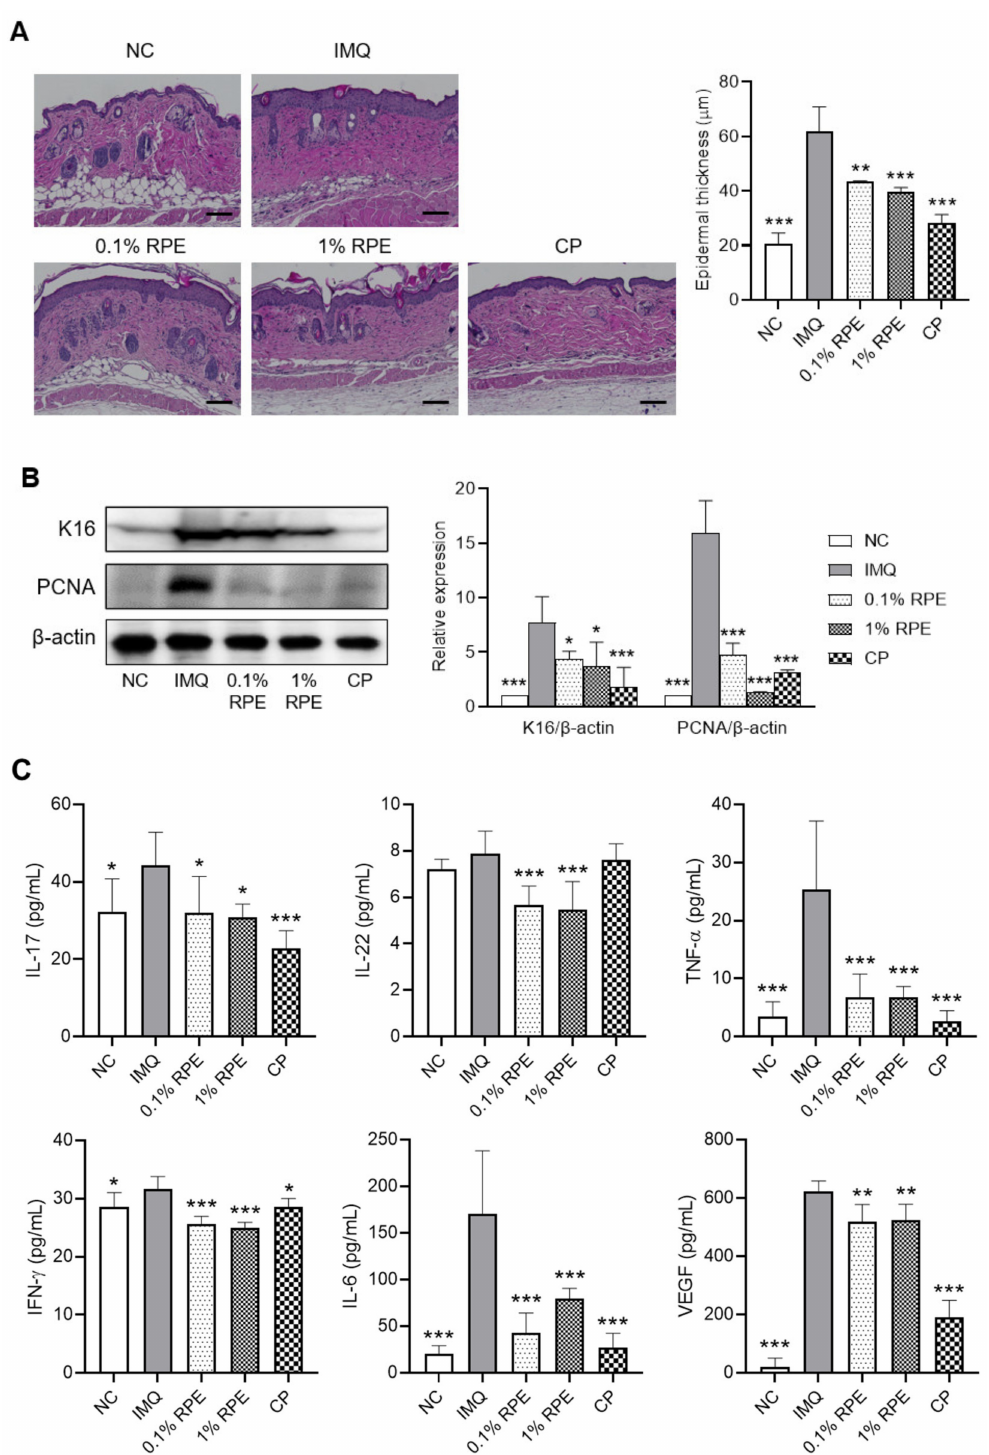
Figure 2. Effects of RPE on epidermal hyperplasia and the expression of proliferation markers and inflammatory cytokines in IMQ-induced mice. ( A ) H&E staining of skin lesions. Scale bar: 200 µ m. Epidermal thickness was evaluated. ( B ) The levels of proliferation markers K16 and PCNA in skin lesions were measured by Western blotting. ( C ) Skin tissue levels of inflammatory cytokines, including IL-17, IL-22, TNF- α , IFN- γ , IL-6, and VEGF, were measured. Data are expressed as means ± SDs ( n = 6 per experiment). * p < 0.05, ** p < 0.01, *** p < 0.001 vs. the IMQ group. NC: normal control, IMQ: imiquimod, RPE: Rheum palmatum L. extract, CP: clobetasol propionate, PCNA: proliferating cell nuclear antigen, and VEGF: vascular endothelial growth